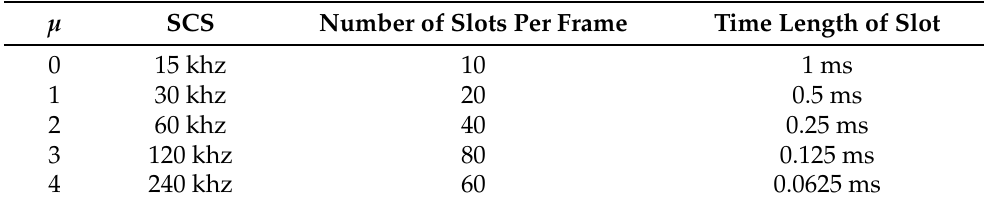
Table 1. Supported transmission numerologies and additional info.